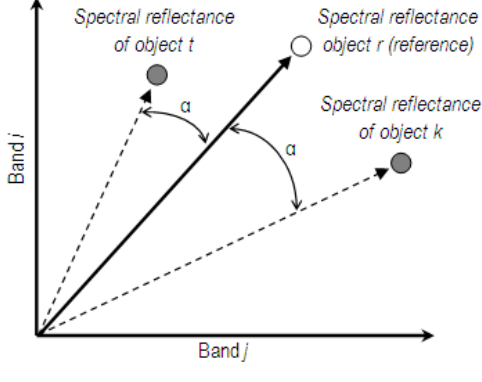
Figure 3. Diagram of spectral angle between vector representation of image pixel